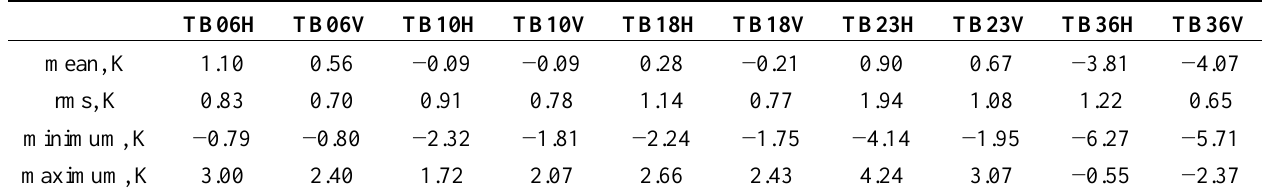
Table 5. Descriptive statistics of the differences between measured and calculated brightness temperatures for Aqua AMSR-E instrument for cloudless